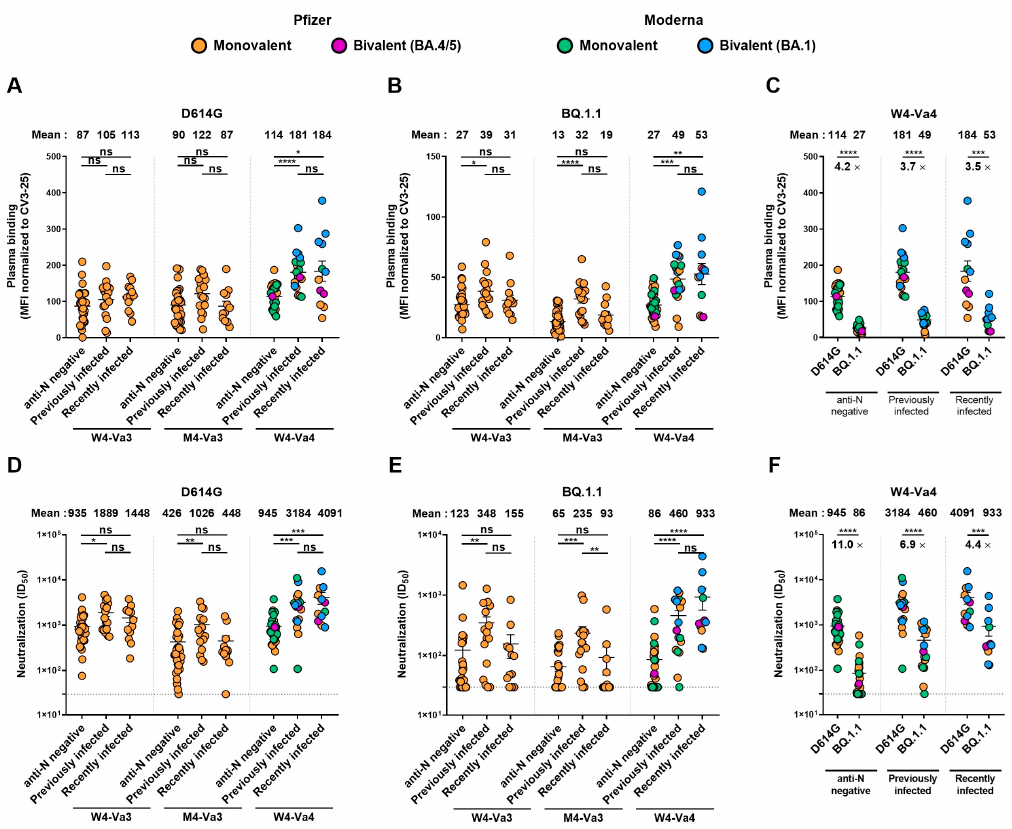
Figure 3. Recognition and neutralization of the D614G and BQ.1.1 Spikes in anti-N negative, previ- ously infected or recently infected individuals. ( A – C ) 293T cells were transfected with the full-length D614G or BQ.1.1 S, stained with the CV3-25 mAb or with plasma from vaccinated individuals and analyzed by flow cytometry. The values represent the MFI normalized by CV3-25 mAb binding. ( D – F ) Neutralization activity was measured by incubating pseudoviruses bearing SARS-CoV-2 S glycoproteins, with serial dilutions of plasma for 1 h at 37 °C before infecting 293T-ACE2 cells. Neu- tralization half maximal inhibitory serum dilution (ID 50 ) values were determined using a normal- ized non-linear regression using GraphPad Prism software. Donors were separated in three differ- ent groups, anti-N negative group, previously infected group, or recently infected group (see Figure 2). Individuals vaccinated with Pfizer monovalent, Moderna monovalent, Pfizer bivalent (BA.4/5) or Moderna bivalent (BA.1) fourth dose are represented by orange, green, purple, and blue points, respectively. Limits of detection are plotted. Error bars indicate means ± SEM (* p < 0.05; ** p < 0.01; *** p < 0.001; **** p < 0.0001; ns, non-significant). 5. Conclusions These results indicate that further efforts have to be devoted to improving vaccines against new SARS-CoV-2 variants of concern. Whether immune responses comparable to those observed with breakthrough infections could be obtained with new vaccine formu- lations remains to be determined.